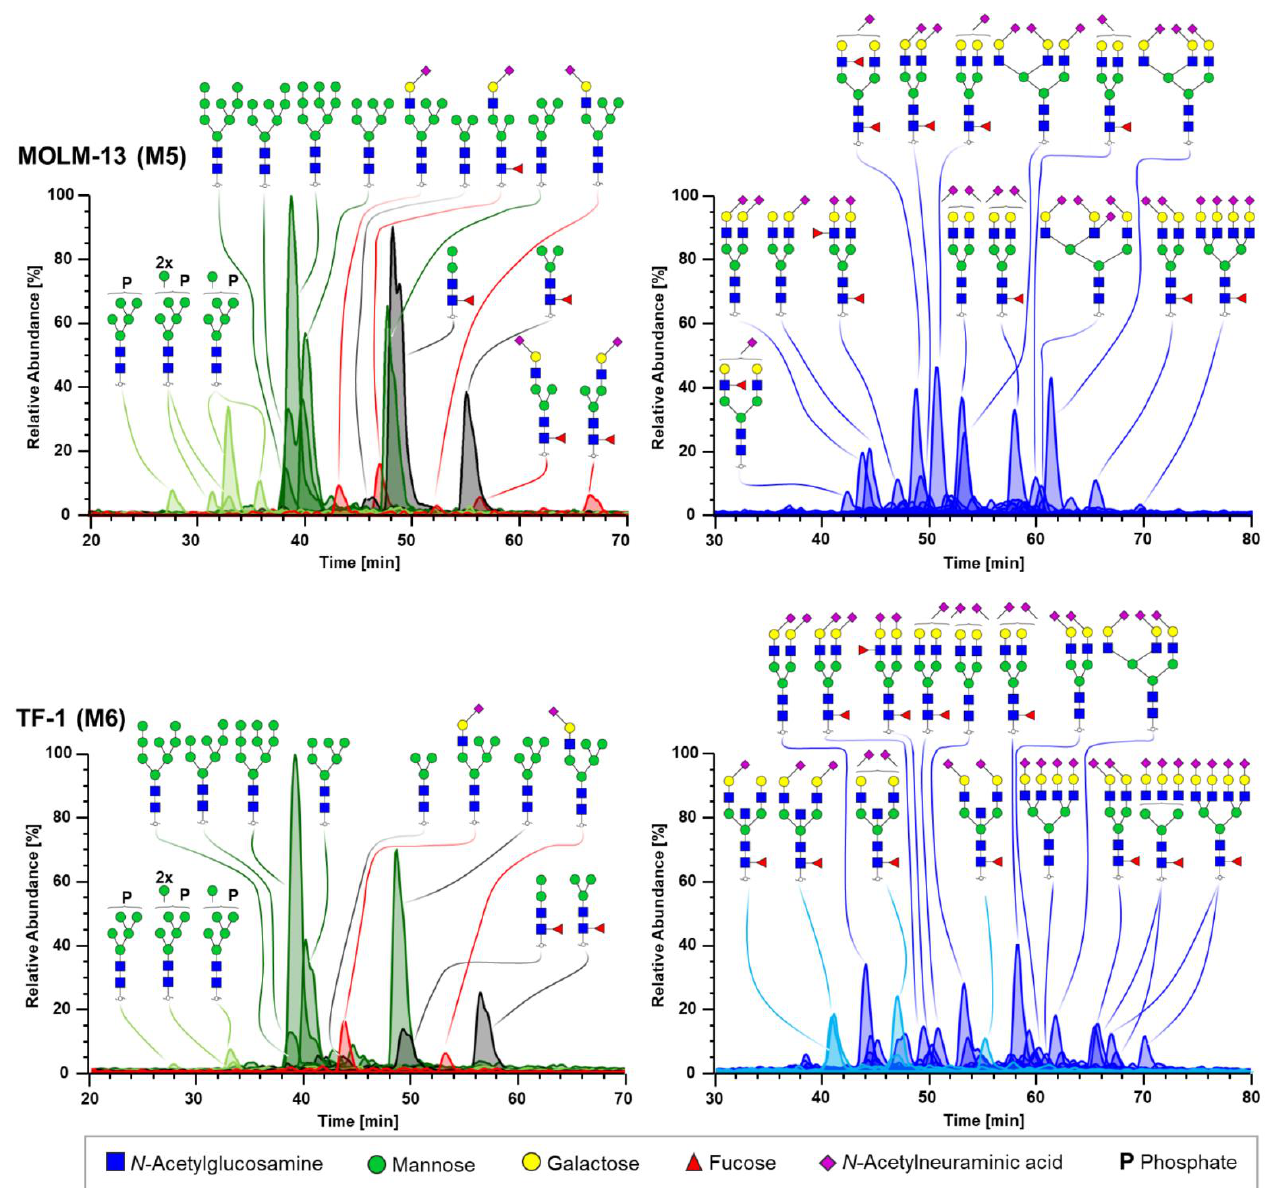
Figure 1. Exemplary combined EICCs of N -glycans obtained for the M5 subtype MOLM-13 ( upper panels ) and the M6 subtype TF-1 ( lower panels ). The most abundant glycans are annotated. Mass traces for oligomannose (dark green), phosphorylated oligomannose (light green), paucimannose (grey), and hybrid type (red) glycans are depicted in the two panels on the left. Traces of complex type (blue) glycans are shown in the right panels for the respective cell line. Bisected complex glycans are illustrated in light blue. Relative abundances are scaled to the most abundant glycan taking into account all of the glycan types. The symbol and color code of monosaccharides used for illustrating glycan structures is depicted beneath the panels. Sialic acids in α -2,3 linkage are tilted to the left, α -2,6 are tilted to the right, and sialic acids in unknown glycosidic linkage are displayed with a vertical connection.